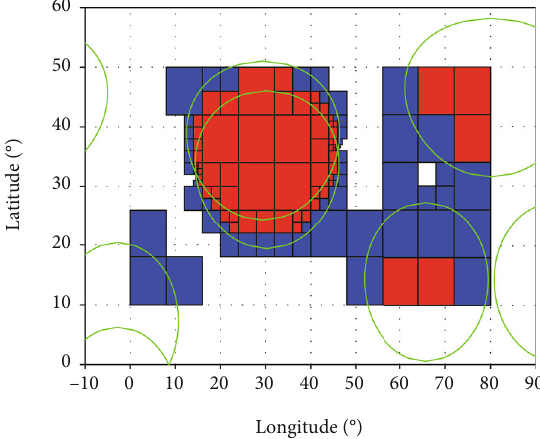
Figure 12: The coverage region of simulation for target-1.